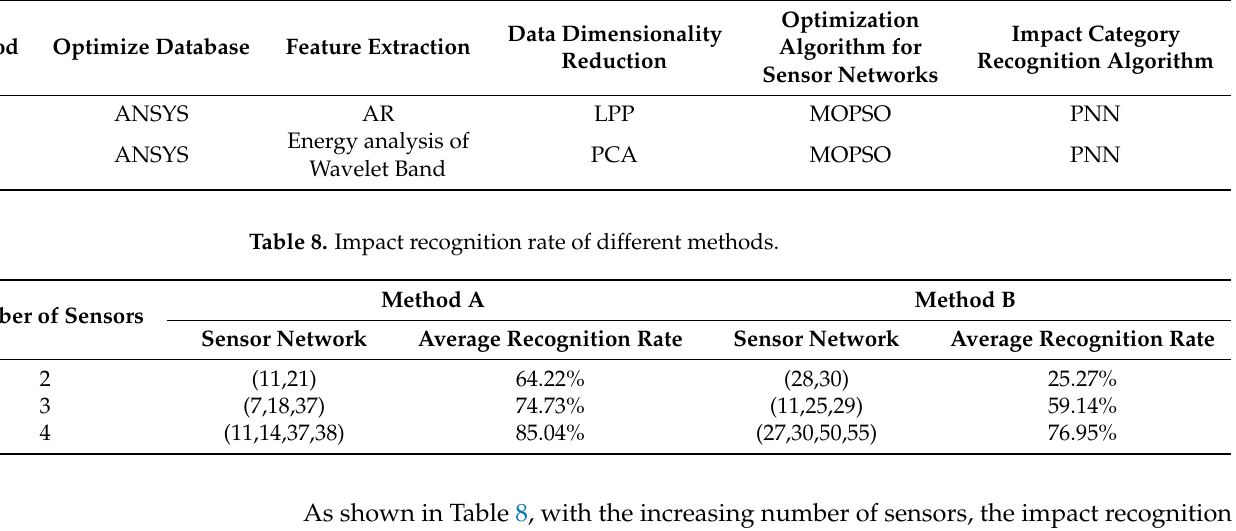
Table 7. Specific information about different methods.